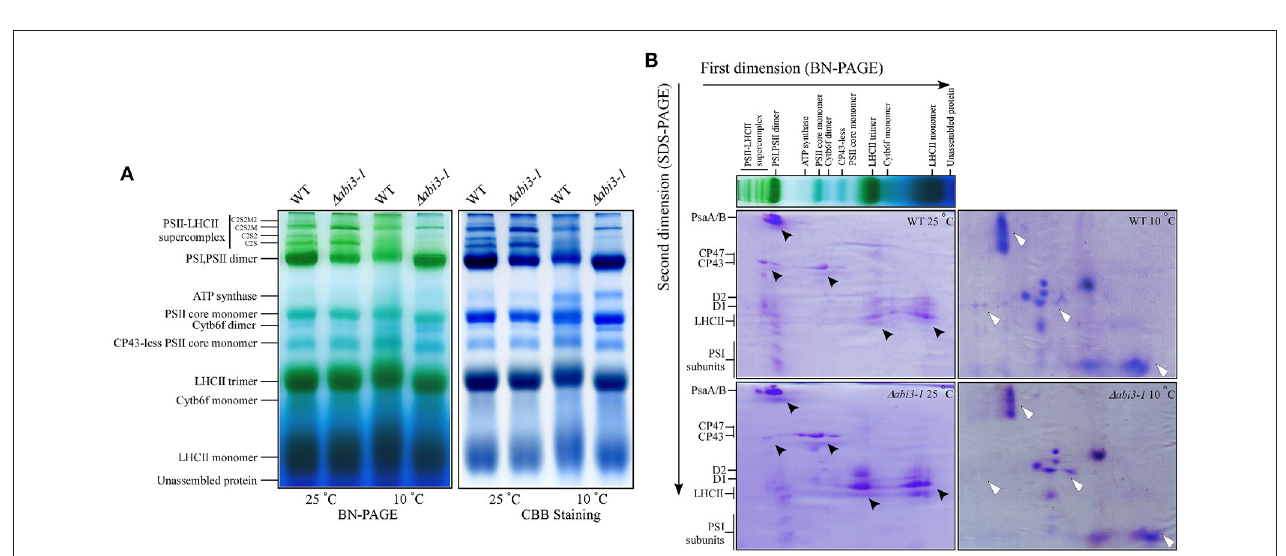
FIGURE 8 | Deletion of PpABI3 affects assembly of PSII during cold acclimation. (A) Blue Native (BN)-gel electrophoresis analysis of thylakoid membrane protein complexes. Thylakoid membranes were isolated from WT and ∆ abi3-1 with or without cold acclimation, then solubilized with 2% DM and separated by BN-PAGE. A sample with an equal amount of chlorophyll (25 µ g) was loaded in each lane. The BN gel (left) was further stained with Coomassie Brilliant blue (CBB; right). (B) Two-dimensional (2D) separation [BN-gel follows SDS-PAGE] of thylakoid protein complexes. Complexes in BN-gel were subsequently separated by SDS-urea-PAGE and stained with CBB to show their constituent subunits. Protein distribution differences between WT and ∆ abi3-1 were indicated by triangle symbol (black, standard condition; white, after cold acclimation).